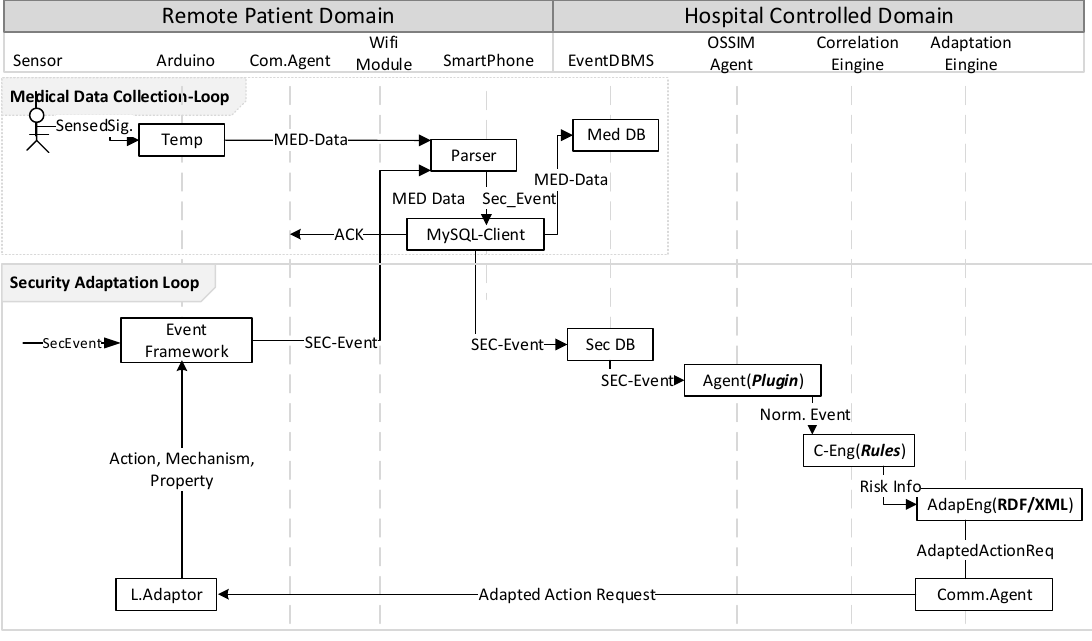
Figure 12. EDAS message sequence